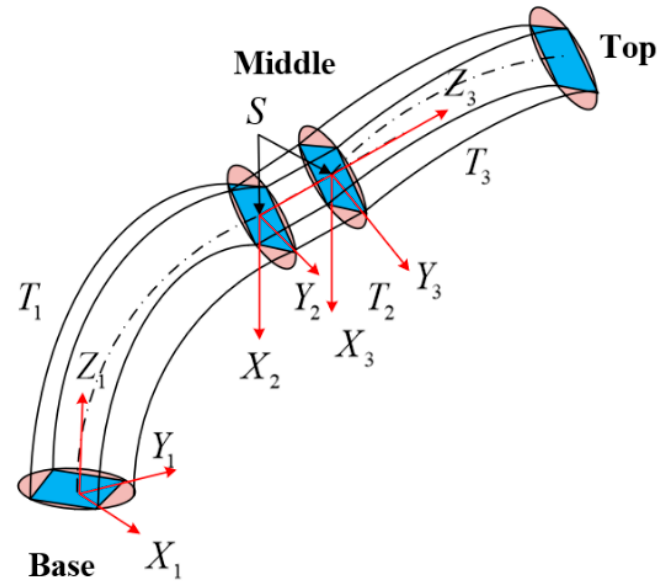
Figure 5. MHTM of multisection continuum arms.